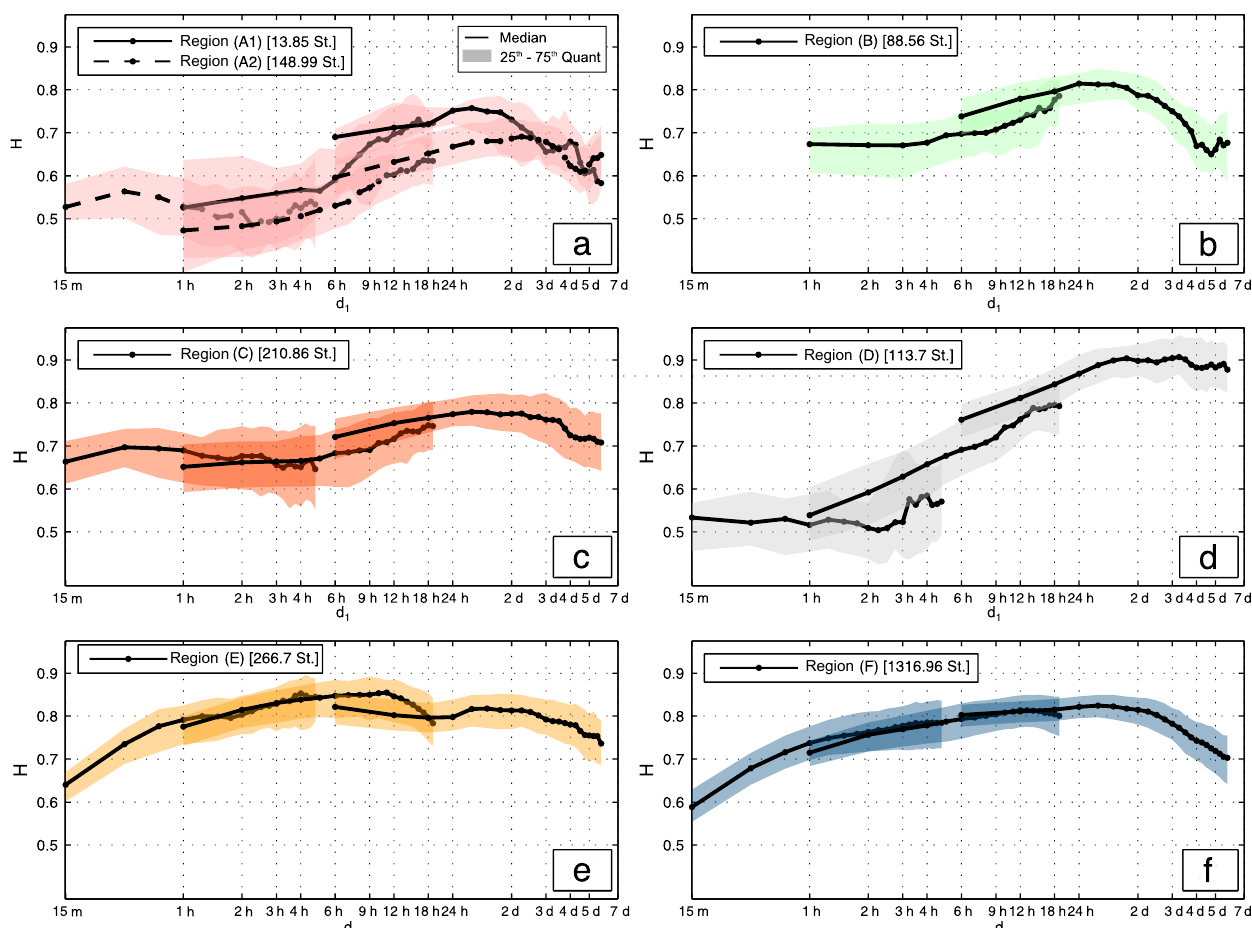
Figure 8. Median and interquantile range (IQR) of the scaling exponent distribution over valid SS stations within each region of Fig. 7 for 6-duration scaling intervals for the SD (left curve), ID (central curve), and LD (right curve) datasets. For each region, the mean number of valid SS stations over the scaling intervals is indicated in brackets in the legend. See Fig. 7 for region